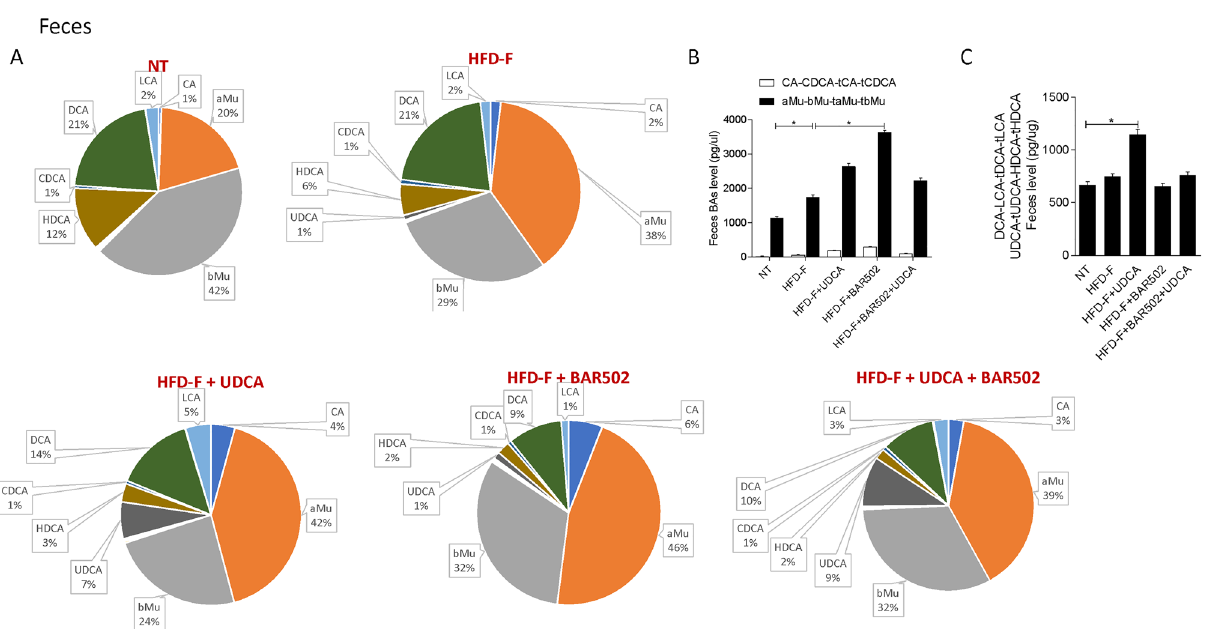
Figure 11. ( A ) Composition of fecal bile acid pools. ( B ) Fxr agonist and antagonist bile acids content in feces. ( C ) Concentration of Gpbar1 agonist bile acids. Each result is the mean ± SEM of 7–11 mice per group. *p ≤